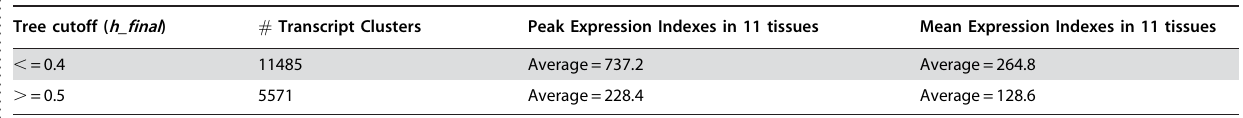
Table 1. The impact of gene expression levels on probe selection .. ... .... ... ... .... ... ... .... ... ... .... ... ... .... ... ... .... ... ... .... ... ... .... ... ... .... ... ... .... ... ... .... ... ... .... ... ... .... ... ... .... ... ... . Tree cutoff